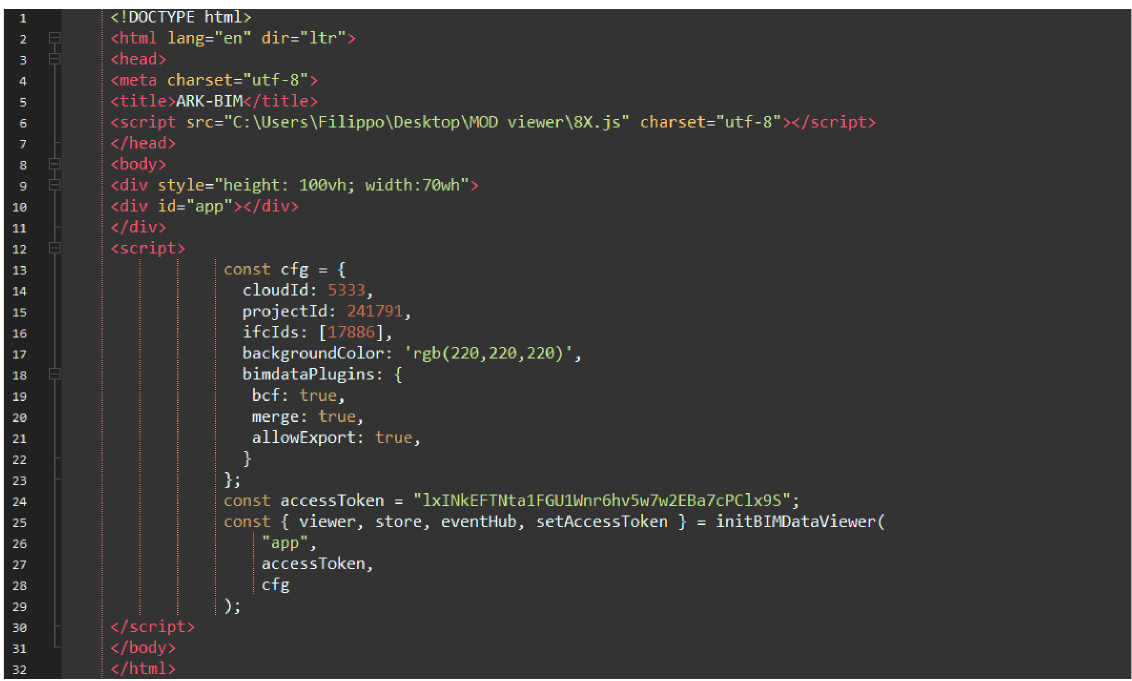
Figure 7. HTML viewer code (interface without plugins): main viewer link on line 6; IFC model coordinates on lines 14–16; identification token on line 2.